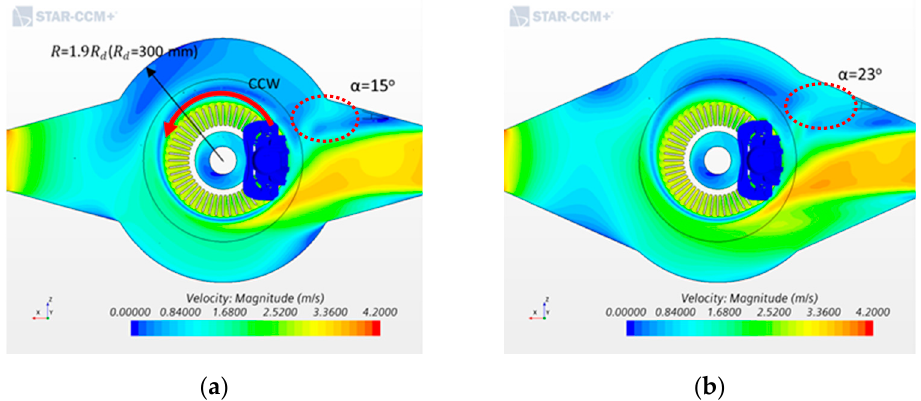
Figure 7. Flow velocity magnitude for the inlet and outlet angles of the enclosure: ( a ) α = 15°; ( b ) α = 23°.